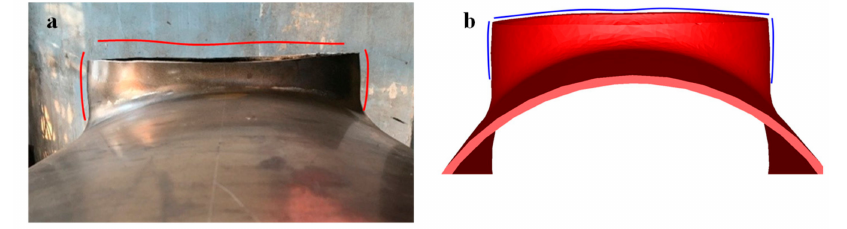
Figure 12. Shape of branch: ( a ) experiment; ( b )